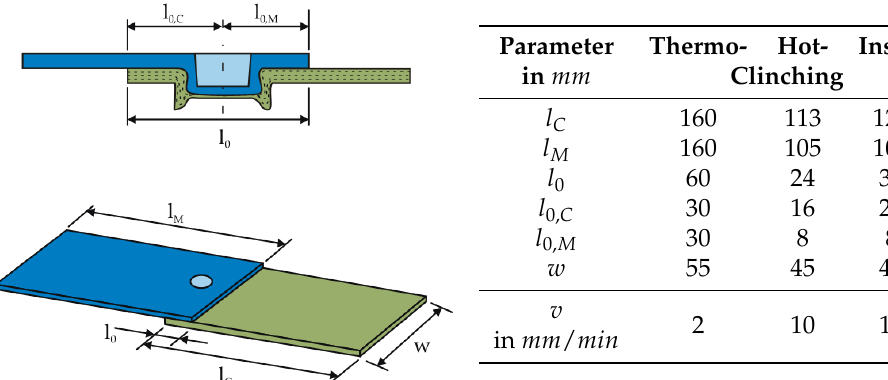
Figure 9. Specification and dimensions of the single-lap shear test specimens for the different clinching technologies.